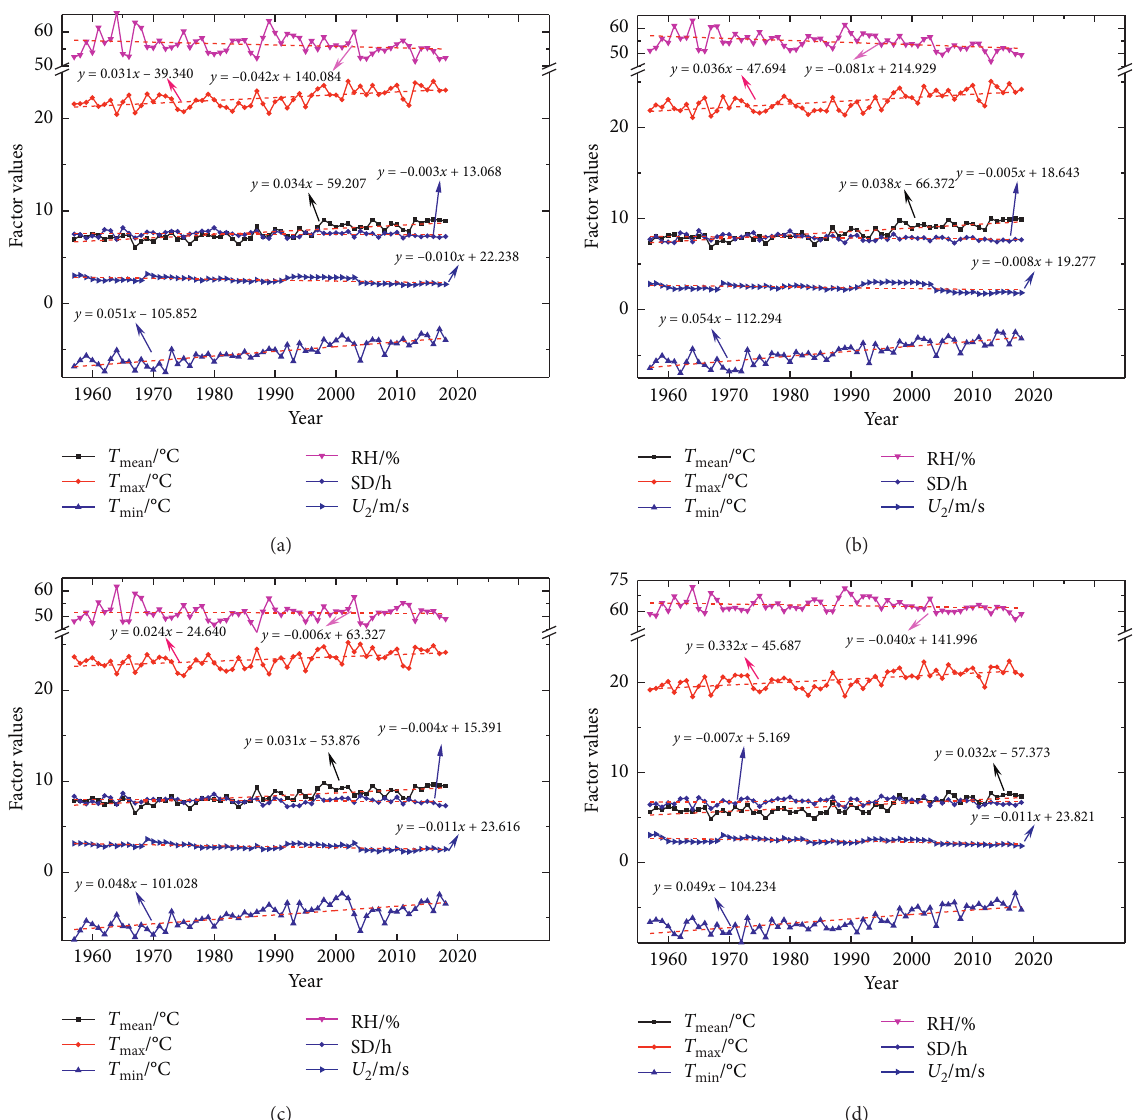
Figure 3: Annual variations in spatially averaged values of climate data (average temperature ( T mean ), maximum temperature ( T max ), minimum temperature ( T min ), relative humidity (RH), sunshine duration (SD), and wind speed ( U 2 ) from 1957 to 2018 in different climate zones):